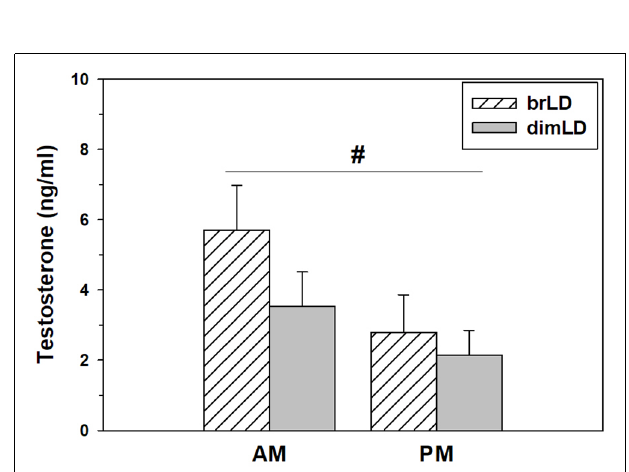
FIGURE 2 | Hormonal response to dim daylight. Circulating levels (Mean ± SEM) of testosterone in male grass rats housed in bright daylight intensity condition (brLD) or dim daylight intensity (dimLD) condition, and sacrificed during the day (hatched) or night (gray). # Significant main effect of time of day, p <